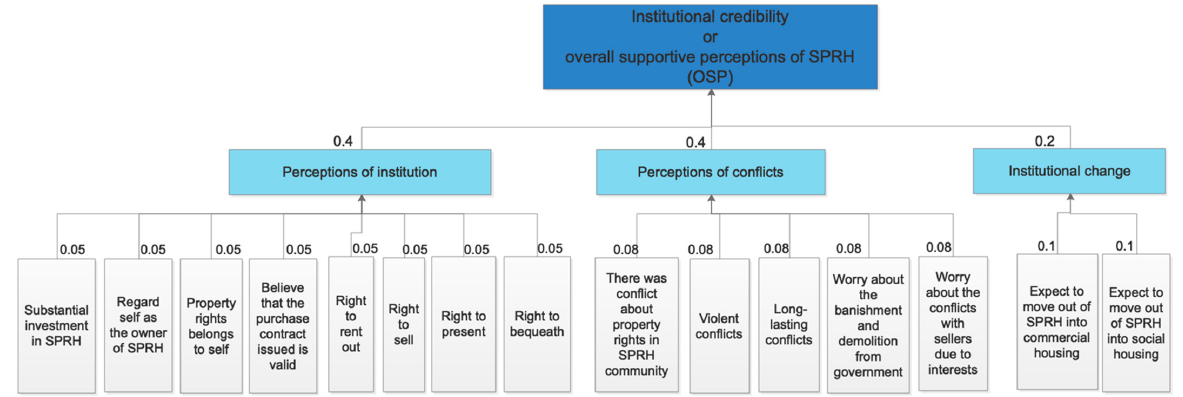
Figure 3. The weightings of indicators contributing to OSP determined by AHP (by the first author).